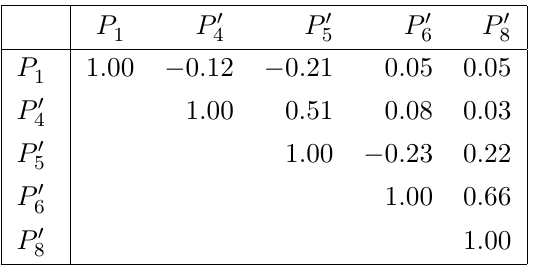
Table 7 . Statistical correlation matrix for the P (